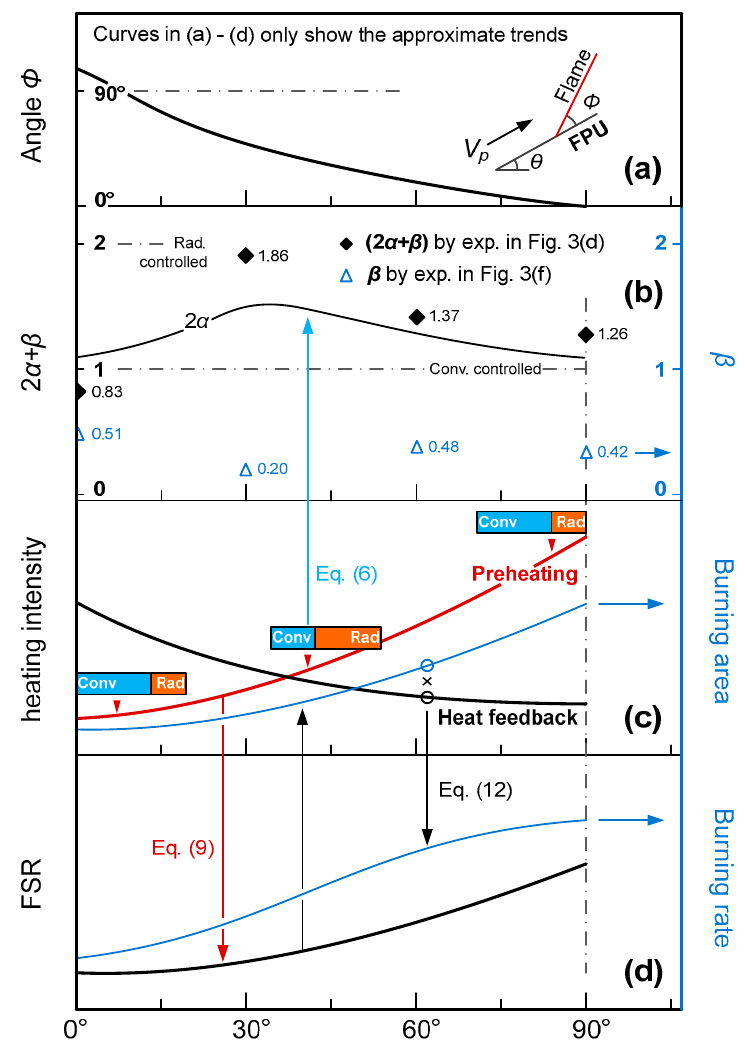
Figure 4. Variation tendencies of flame tilt ( a ), pressure indexes ( b ), heat transfer intensity ( c ) and burning characteristics ( d ) by influences of inclination or pressure.